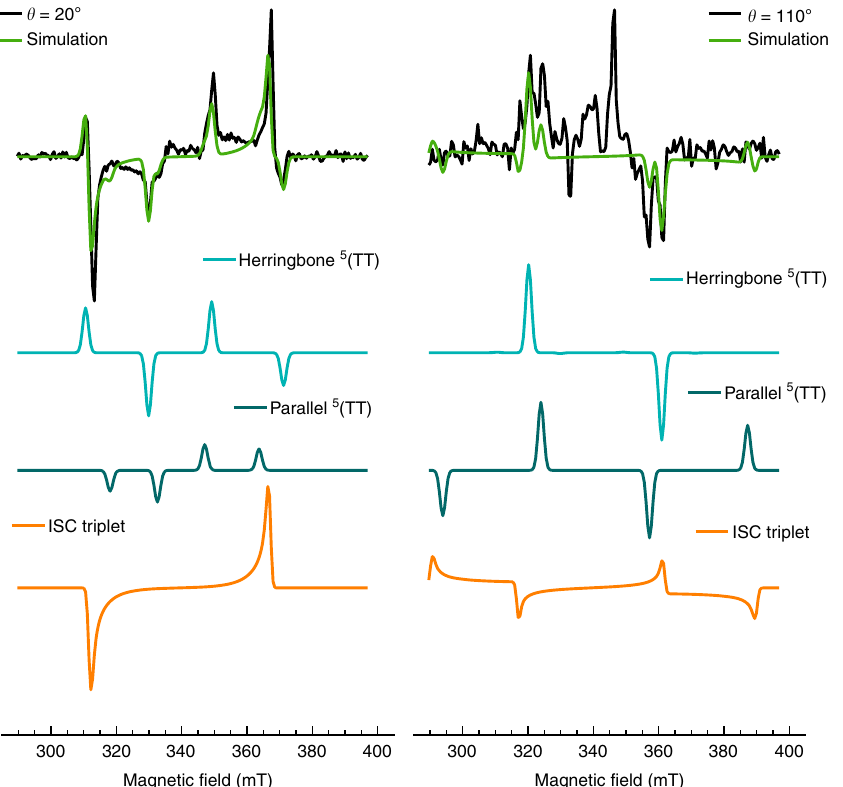
Fig. 6 Evidence of multiple spin species resulting from singlet fi ssion at room temperature. The experimental spectra (black) can be fi tted (green) with a superposition of simulated peaks for the herringbone (cyan) and parallel (teal) dimer arrangement of strongly coupled triplets as well as the intersystem crossing triplet (orange). For the 110° orientation, the additional peaks that are not simulated are due to in-plane disorder, as veri fi ed using an S = 2 fi t with an ordering parameter shown in Supplementary Fig. 7. Spectral slices were taken at the maximum signal, time = 500 ns Table 1 Comparison of the fi tted parameters derived in this work with previously reported data on analogue systems